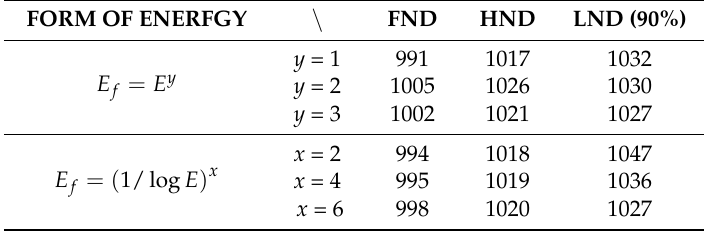
Table 7. Network lifetime with different forms of energy after